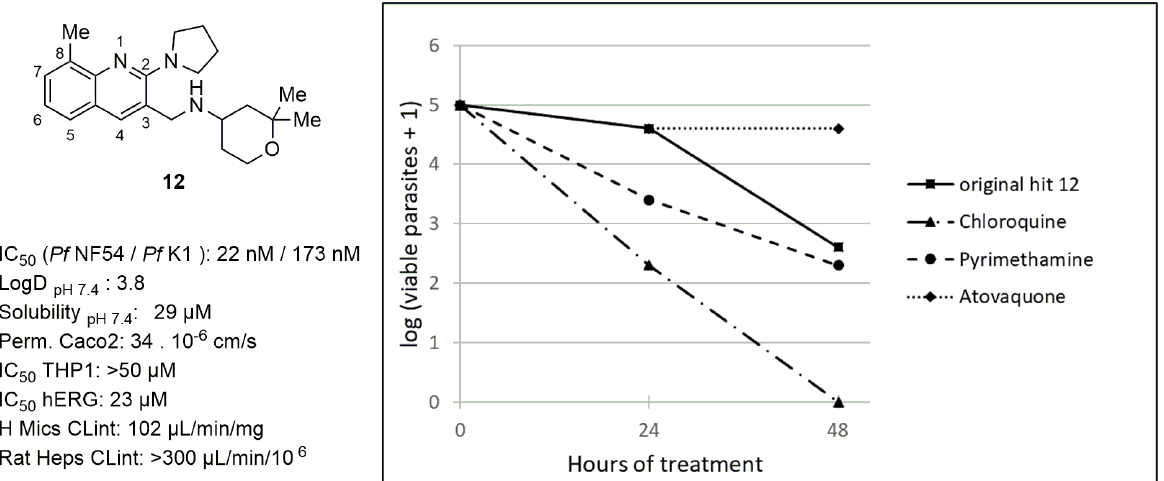
Figure 2 - Original Hit profile (left) and speed of killing plot (right) of viable parasites after treatment with antimalarial drugs and compound 12